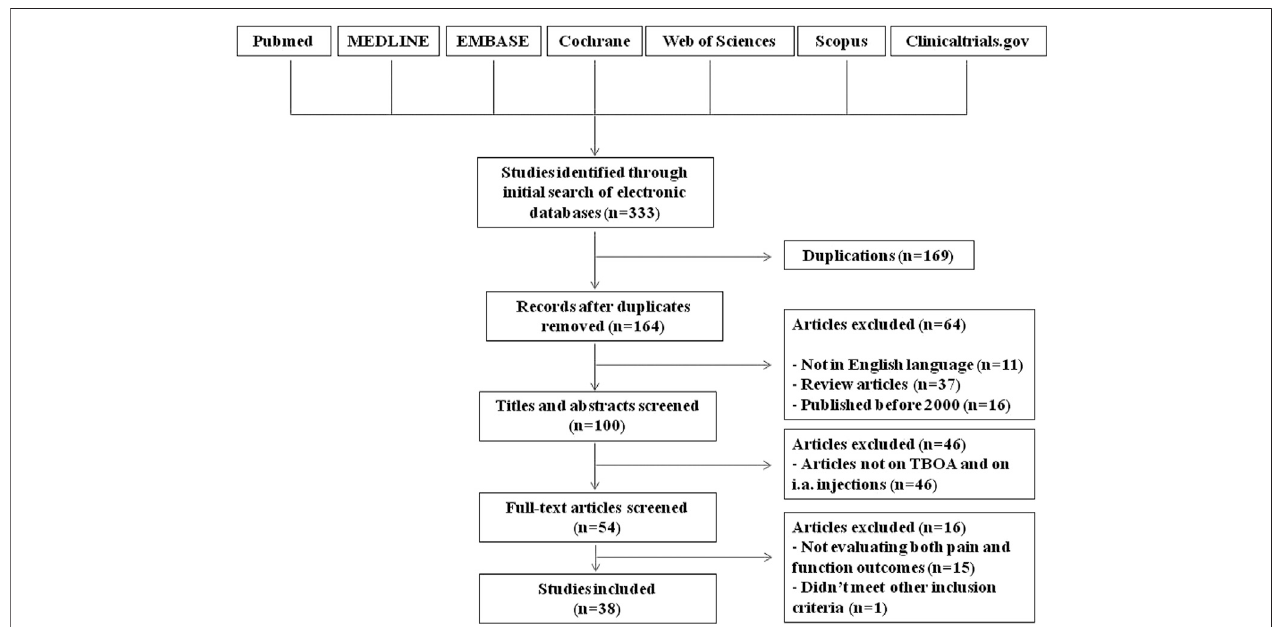
FIGURE 1 | Study fl ow diagram. TBOA, thumb-base